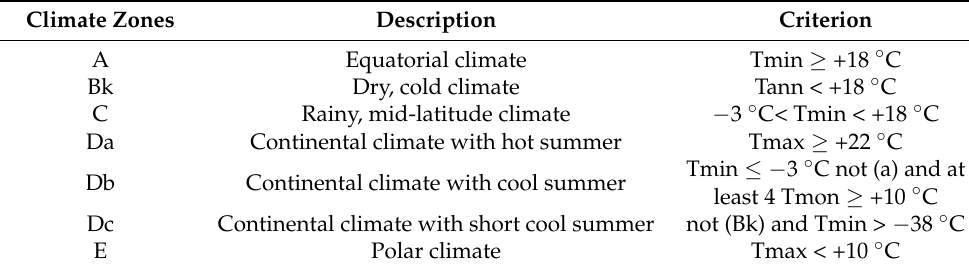
Table 2. Classification of Köppen climate